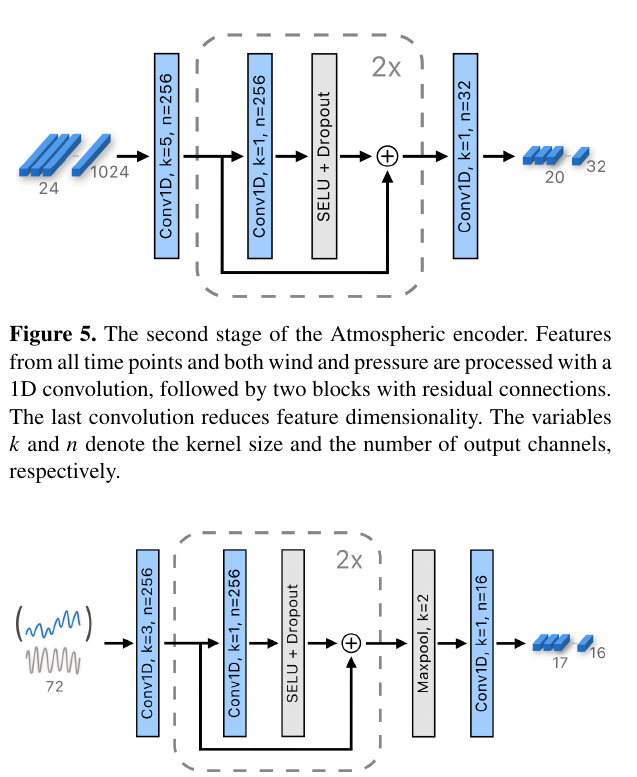
Figure 6. The SSH encoder encodes a concatenation of the past SSH and tide by a 1D convolution, followed by two blocks with residual connections, max-pooling temporal reduction and convolution-based feature reduction. The variables k and n denote the kernel size and the number of output channels,